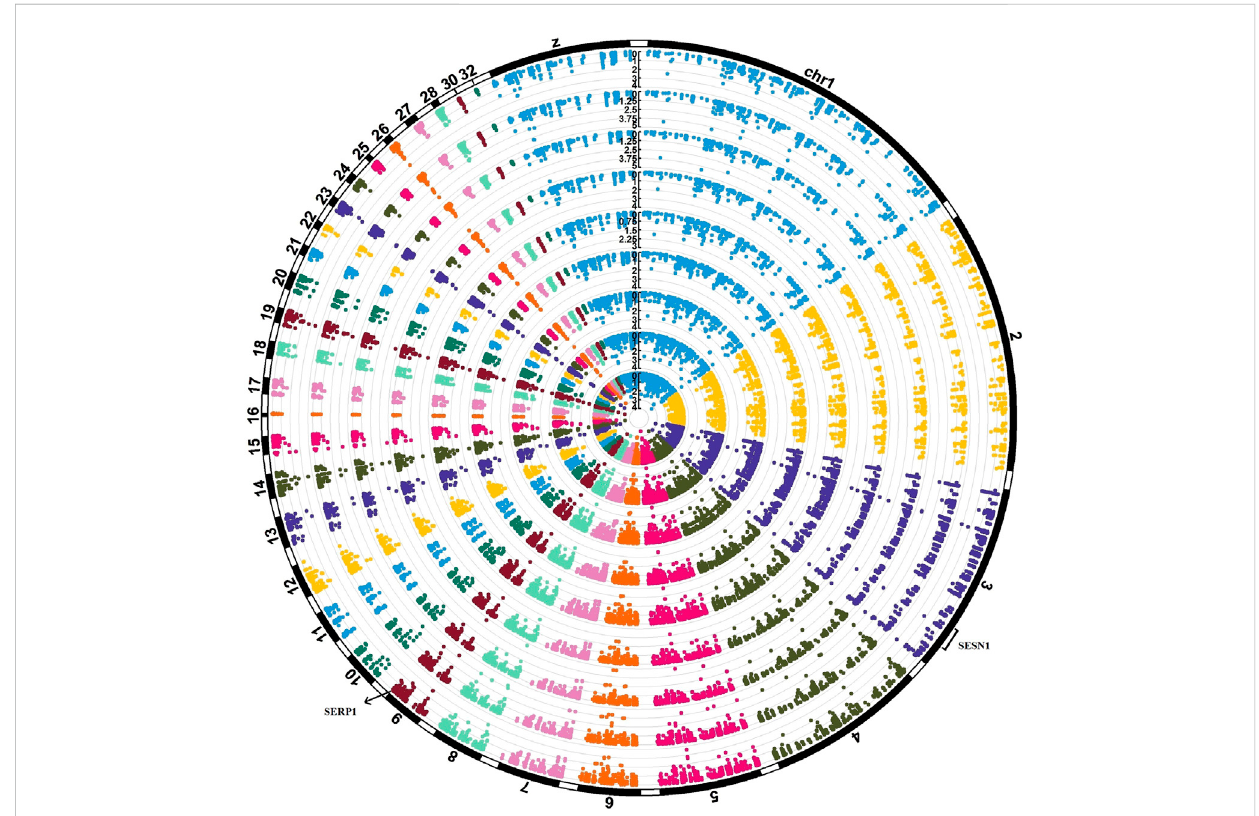
FIGURE 8 CircularManhattanplotthatvisualizedtheassociationofeSNPswiththeeigenvaluesofninemodules(layersofcircles).TheeSNPswerecalledfrom the RNA-seq data of 32 chickens. Four eSNPs in SESN1 meta-gene (positions chr3:67138413, 67135835, 67137358, 67137810) and one eSNP on the SERP1 meta-gene (position chr9:23805255) were found to be associated with all nine modules.